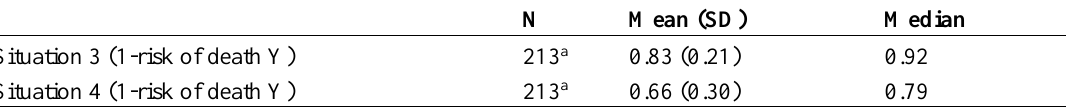
Utility of the brown health state (severe hemophilia) without risk of death from blood-borne disease (situation 3) and with risk of death from blood- borne disease (situation